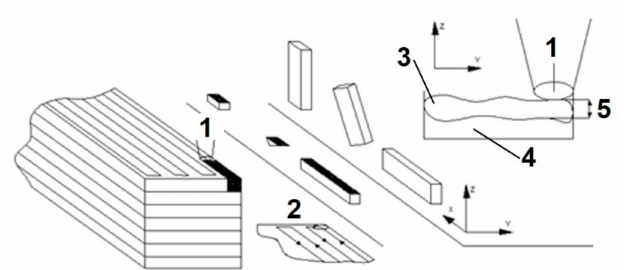
Figure 2. Schematic principle of SLM technology (scales are not respected), where: ( 1 ) laser beam; ( 2 ) laser path; ( 3 ) melted power; ( 4 ) powdered bed; ( 5 ) layer